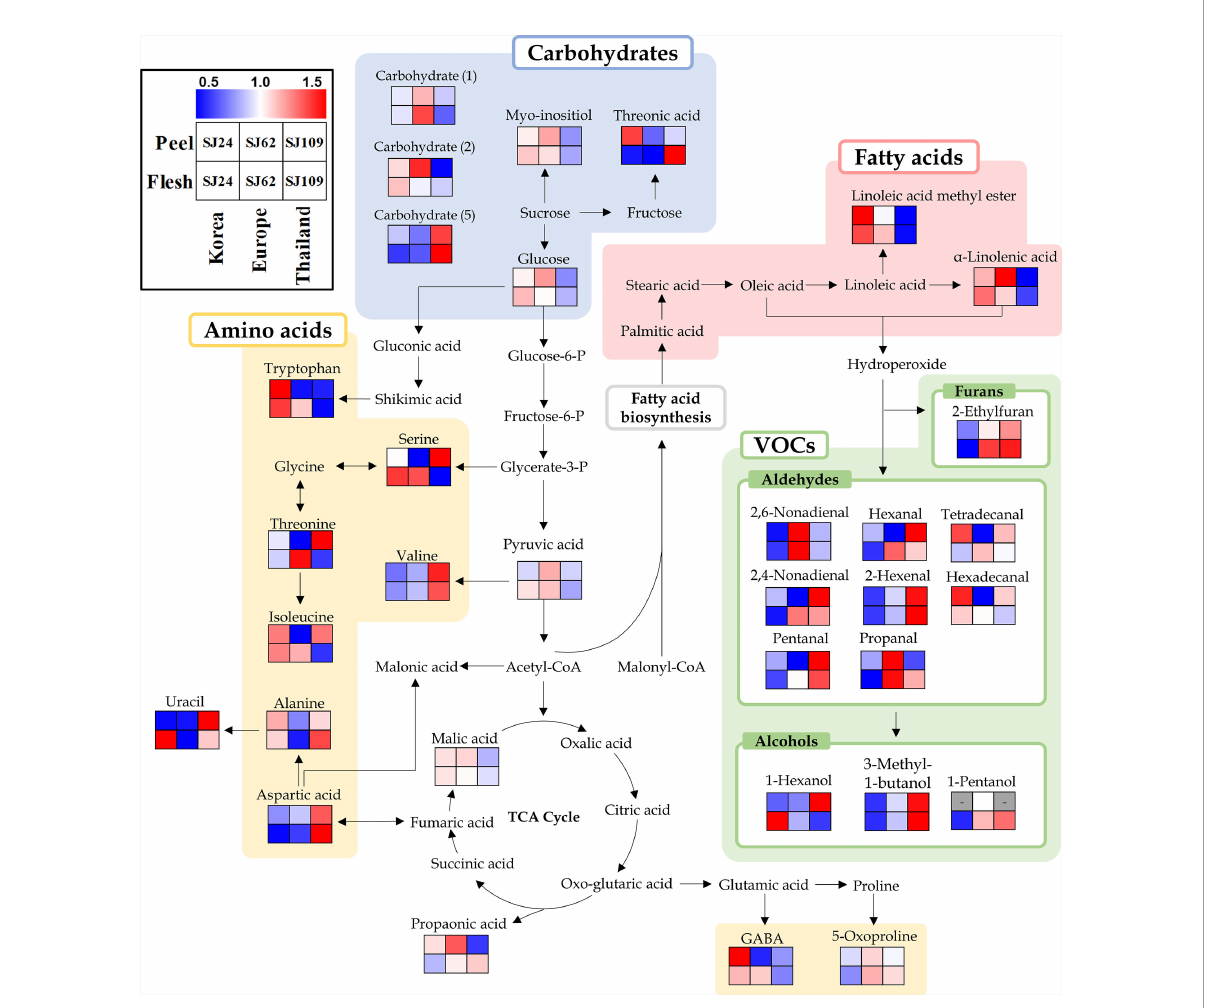
FIGURE 4 Schematic diagram of the biosynthetic pathway and relative content of metabolites in SJ24, SJ62, and SJ109 cucumbers. The pathway was modi fi ed from the Kyoto Encyclopedia of Genes and Genomes (KEGG) database (http://www.genome.jp/kegg/). The colored squares (blue-to-red) represent the relative